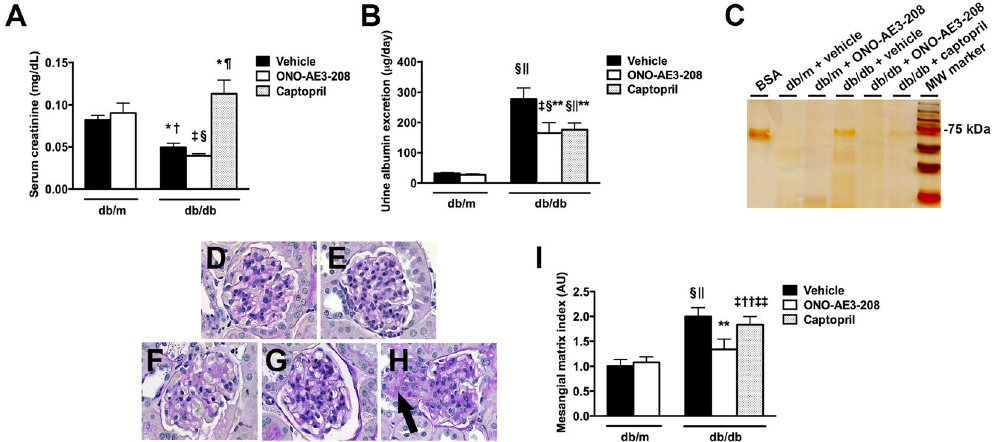
Figure 3. Renal function and mesangial matrix in non-diabetic db/m and diabetic db/db mice treated with vehicle (drinking water) or ONO-AE3-208 for eight weeks or db/db mice treated with captopril for eight weeks. db/m + vehicle n = 12, db/m + ONO-AE3-208 n = 12, db/db + vehicle n = 10, db/db + ONO-AE3-208 n = 7, db/db + captopril n = 8. ( A ) Serum creatinine. ( B ) Urine albumin excretion. ( C ) Silver-stained polyacrylamide gel of urine samples from db/m and db/db mice treated with vehicle, ONO-AE3-208 or captopril, after loading according to urine creatinine concentration. ( D – H ) Representative photomicrographs of periodic acid-Schiff stained kidney sections from ( D ) db/m + vehicle, ( E ) db/m + ONO-AE3-208, ( F ) db/db + vehicle, ( G ) db/db + ONO-AE3-208, ( H ) db/db + captopril. Original magnification × 400. The arrow points to a hyperplastic juxtaglomerular apparatus in the kidney section from the db/db mouse treated with captopril. ( I ) Mesangial matrix index. AU = arbitrary units. BSA = bovine serum albumin (1 µ g), MW = molecular weight. * p < 0.05 vs. db/m + vehicle; † p < 0.01 vs. db/m + ONO-AE3-208; ‡ p < 0.001 vs. db/m + vehicle; § p < 0.0001 vs. db/m + ONO-AE3-208; ¶ p < 0.0001 vs. db/db + vehicle or db/db + ONO-AE3-208; || p < 0.0001 vs. db/m + vehicle; ** p < 0.01 vs. db/db + vehicle; †† p < 0.001 vs. db/m + ONO-AE3-208; ‡‡ p < 0.05 vs.